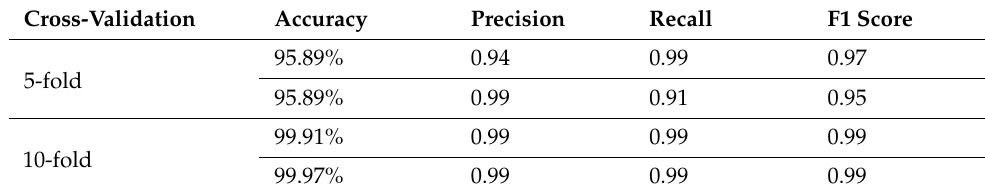
Table 3. Classification results of cotton leaf using Kaggle datasets.